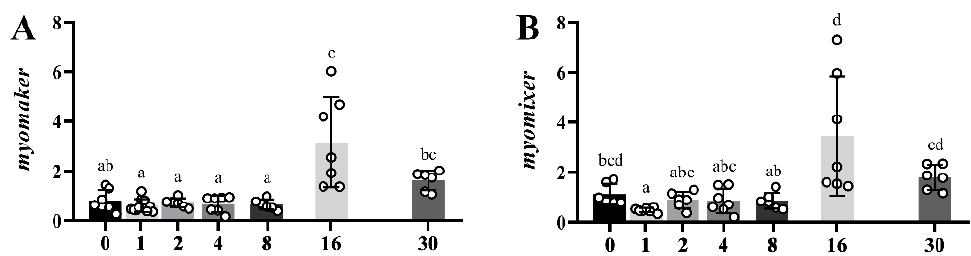
Figure 6. Bar plots of relative gene expression of myomaker ( A ) and myomixer ( B ) along the regenera- tion experiment in white skeletal muscle from day 0 (time of injury) to day 30. White-filled circles represent individual relative gene expression values. Data are presented as means ± SEM ( n = 10). Different letters indicate significant differences ( p < 0.05).